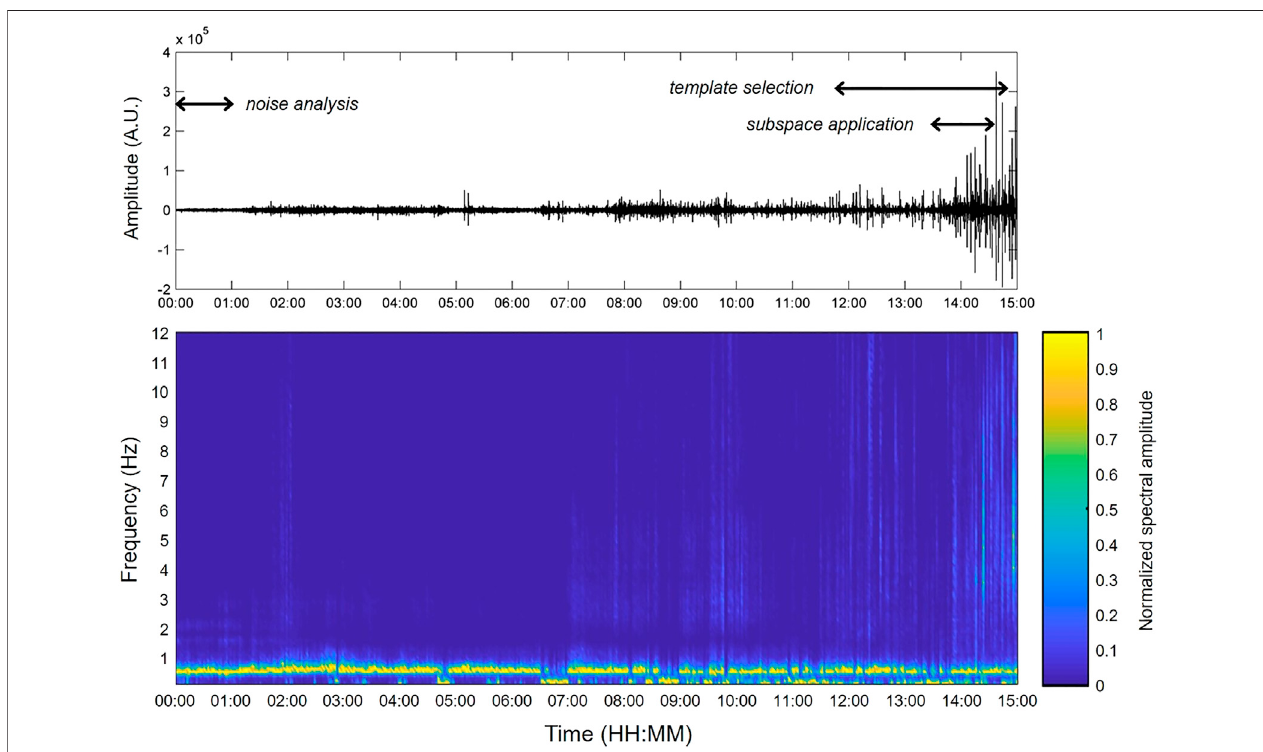
FIGURE 2 | Infrasound signal recorded at EMFO station on May 30, 2019 including the three buffers took into account in this work for statistical parameter estimation (00:00 -01:00), templates selection (12:00 -15:00) and subspace detector application (13:30 -14:30) (top) and normalized spectrogram, where spectra are averaged in 2-min-long windows